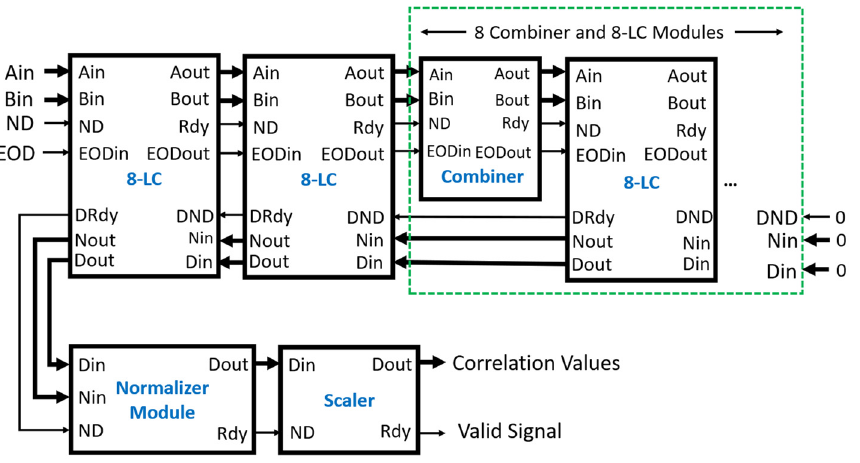
Figure 10. Multi-tau correlator of 80 correlation values output. Input data are supplied to Ain and Bin with the control signals ND and EOD. The output of the correlator is from the Dout of the scaler module. The Din and Nin of the last 8-LC module are set to zero and the DND is set to low.